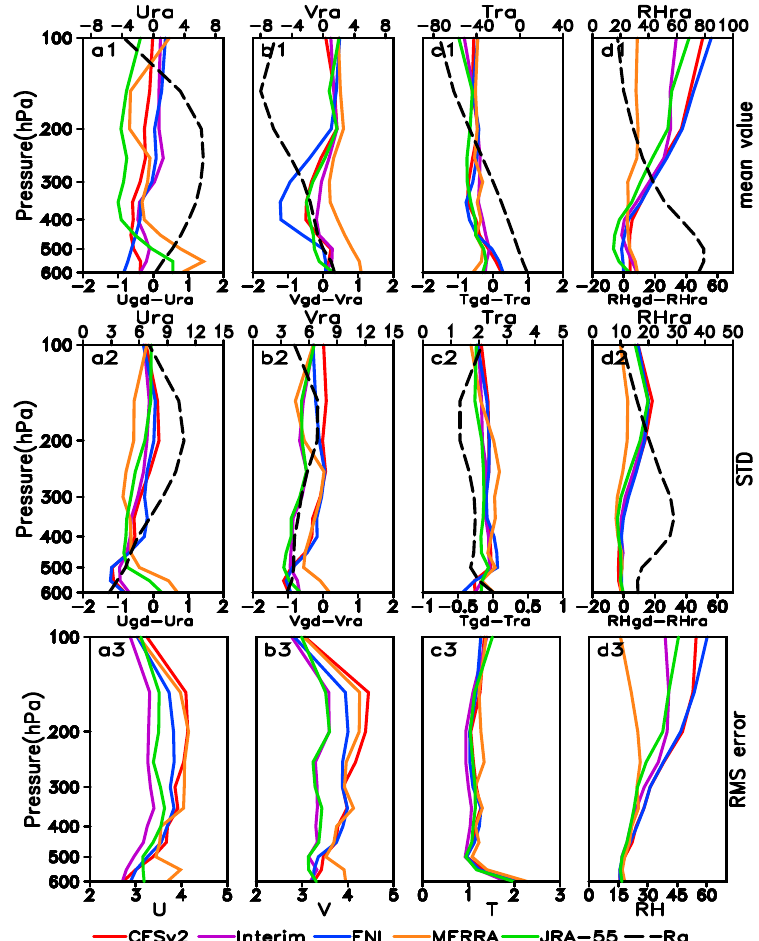
Figure 3. (Top row) Vertical profiles of mean difference (mean bias, color line) between radiosonde data ( U ra, V ra, T ra, RH ra; black dotted line) and gridded datasets (GDs) ( U gd, V gd, T gd, RH gd) in the TP ( a1 ) U (m/s), ( b1 ) V (m/s), ( c1 ) T (°C), ( d1 ) RH (%), all the data ae averaged over six independent